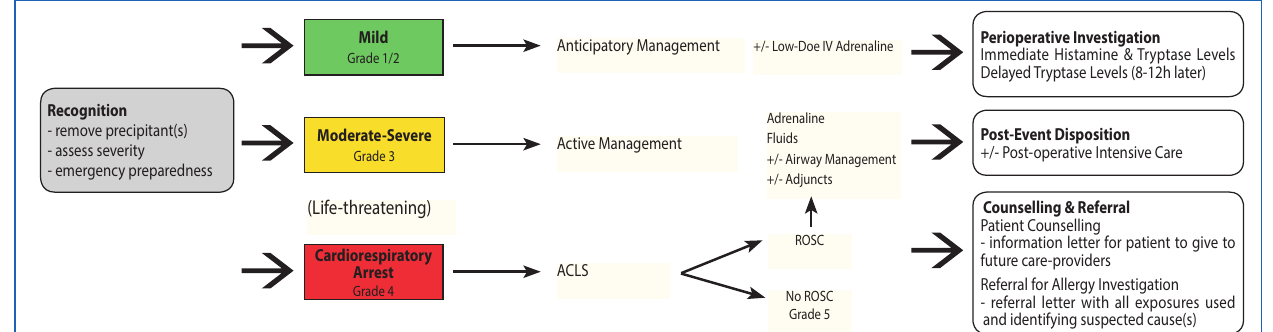
Figure 3: Overview of Management